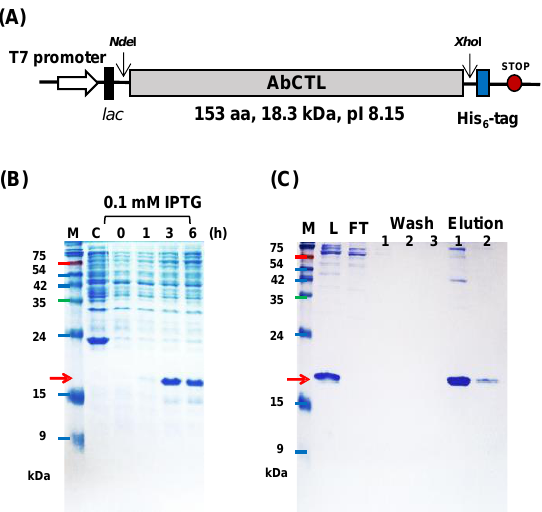
Figure 5. Purification of recombinant AbCTLD (rAbCTLD) expressed in Escherichia coli. ( A ) A schematic representation of the pET–AbCTLD expression vector derived from pET44a (+) . The cloning sites, promoter, and His 6 -tag fusion site are indicated. ( B ) Sodium dodecyl sulfate-polyacrylamide gel electrophoresis (12% acrylamide gel) of E . coli BL21 cell lysates after induction with 0.1 mM isopropyl β -D-1-thiogalactopyranoside (IPTG) at 20 °C for 0, 1, 3, and 6 h. Lane C shows lysate from BL21 cells as a negative control. Lane M contains molecular weight markers; the arrow indicates the expected size of rAbCTLD. ( C ) rAbCTLD was purified on a nickel column under denaturing conditions with 2 M urea. Cell lysate (L), flow through (FT), and wash fractions were loaded onto a 12% acrylamide gel; rAbCTLD was identified in eluted fractions 1 and 2.